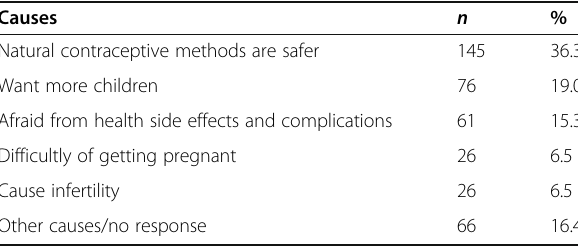
Table 4 Respondents ’ views about hesitancy of some women for using modern contraceptive methods for family planning Causes n Natural contraceptive methods are